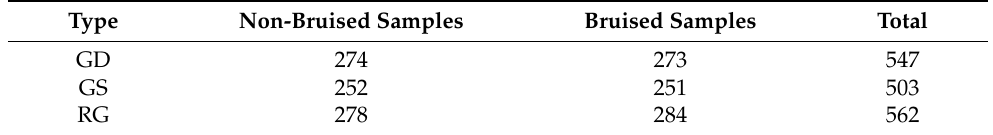
Table 1. Repartition of the number of samples per apple cultivar.